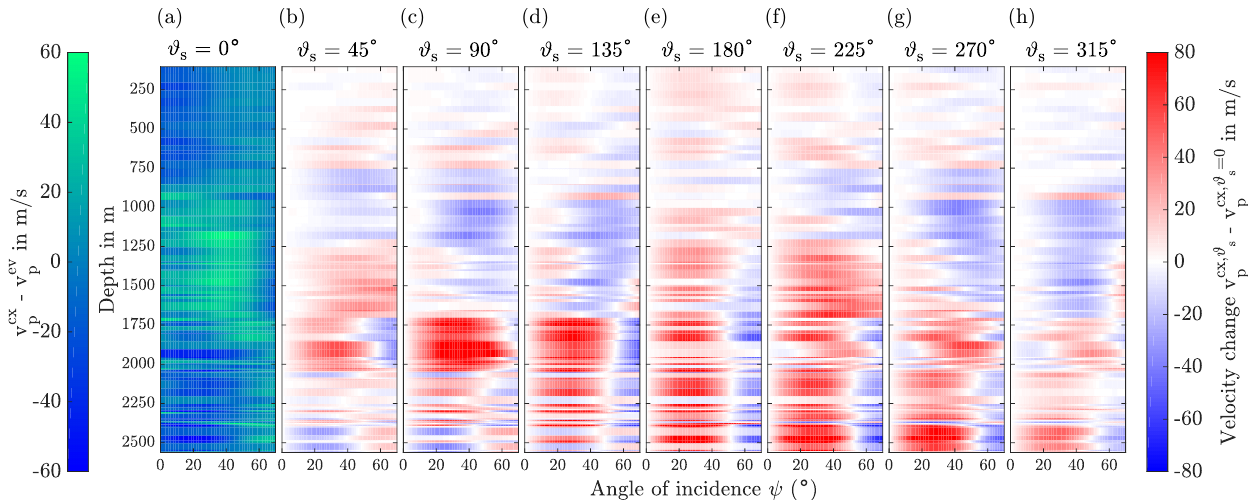
Figure 10. (a) Difference in EDML seismic P-wave velocity between cx and ev frameworks ( v cx p − v ev p ) for incidence angles up to 70 ◦ . (b–h) Change in P-wave velocity as calculated with cx framework for different seismic plane azimuth angles ϑ s compared to ϑ s = 0 ◦ = 0 cx,ϑ s − v cx,ϑ s = 0 = [− 97 , 150 ] ms − 1 ) lie in the saturated range of the colour scale providing a ( v cx,ϑ s p − v cx,ϑ s p ). The extreme values ( v p p better visual contrast (see Table 2). Where the core orientation is insufficiently known and corrected with respect to neighbouring core pieces, vertical variation in velocity in dependence of the incidence angle may not be a true